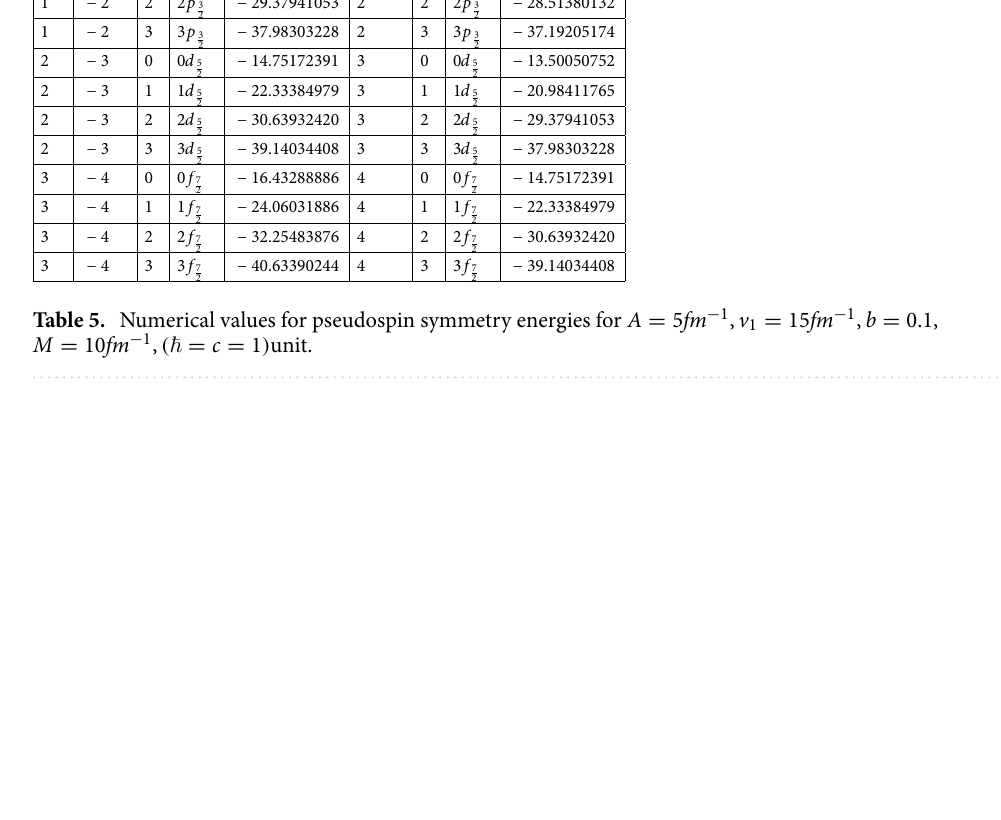
0.4, M 10 fm − 1 , ( (cid:31) = =